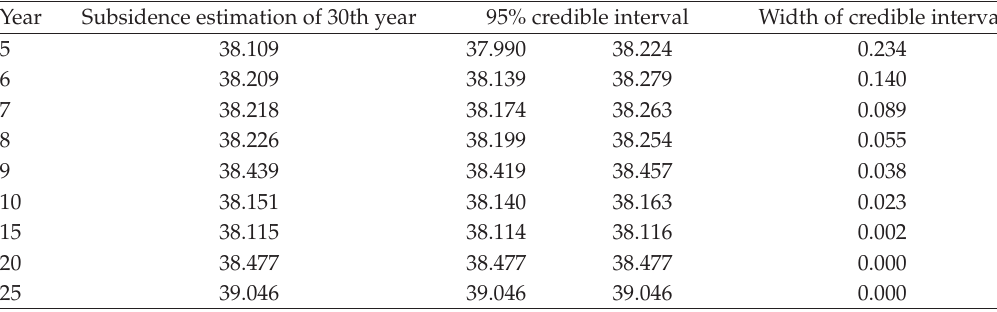
Table 4: Estimation results of ground subsidence amount (cid:6) mesh i (cid:8) 73 (cid:7)